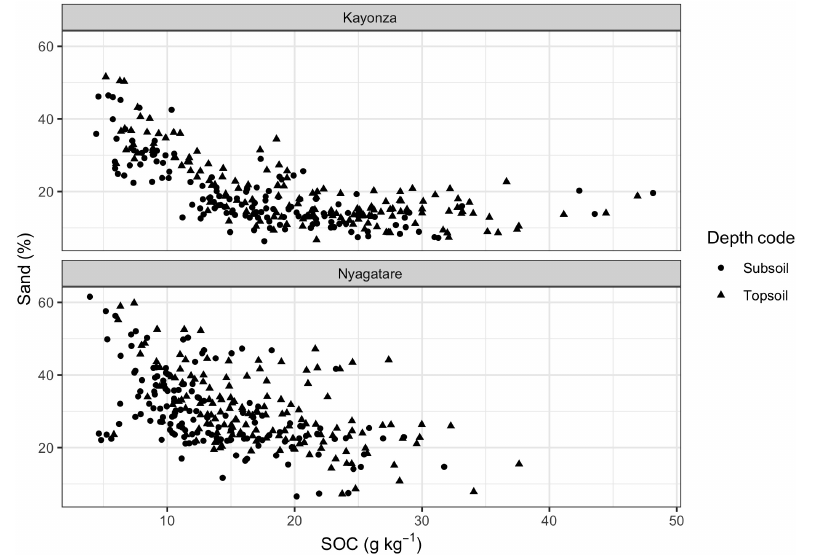
Figure 5. Relationship between sand content and SOC for both topsoil and subsoil samples at the Kayonza and Nyagatare LDSF sites, Rwanda.